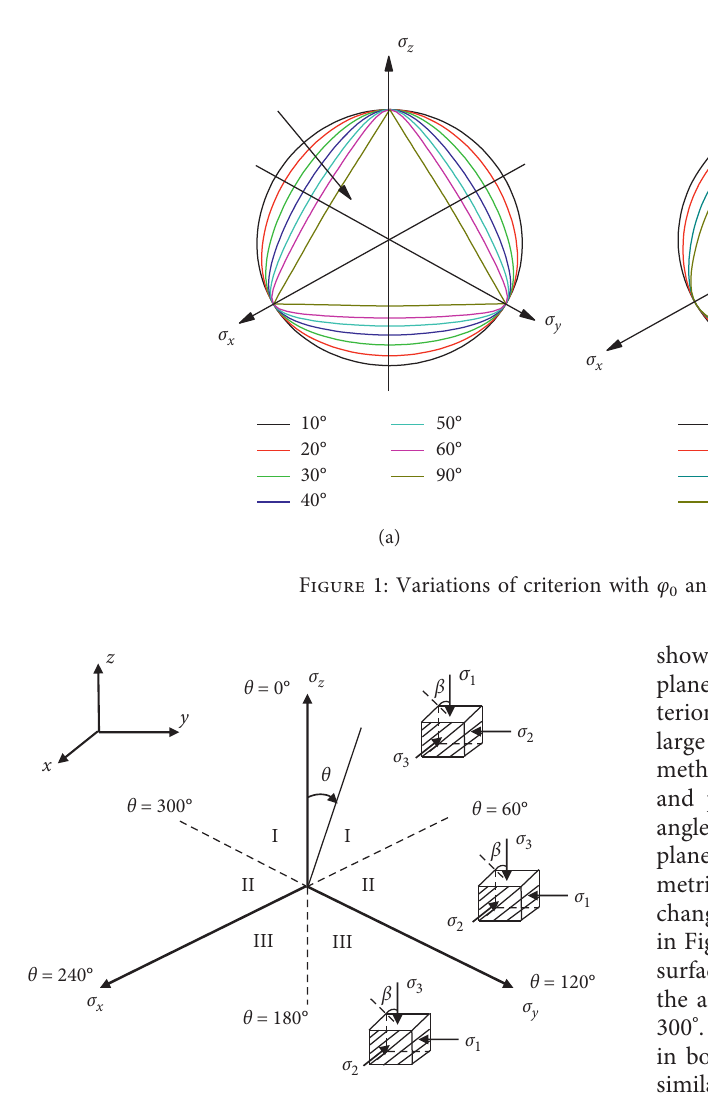
Figure 2: Application of true triaxial tests on cross-anisotropic soils in the octahedral